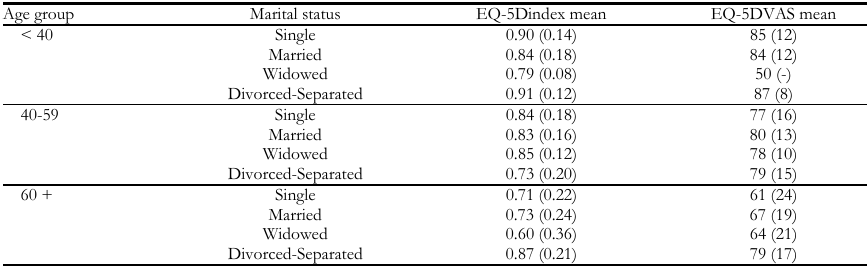
EQ-5D index mean and VAS mean for gender, age group and marital status